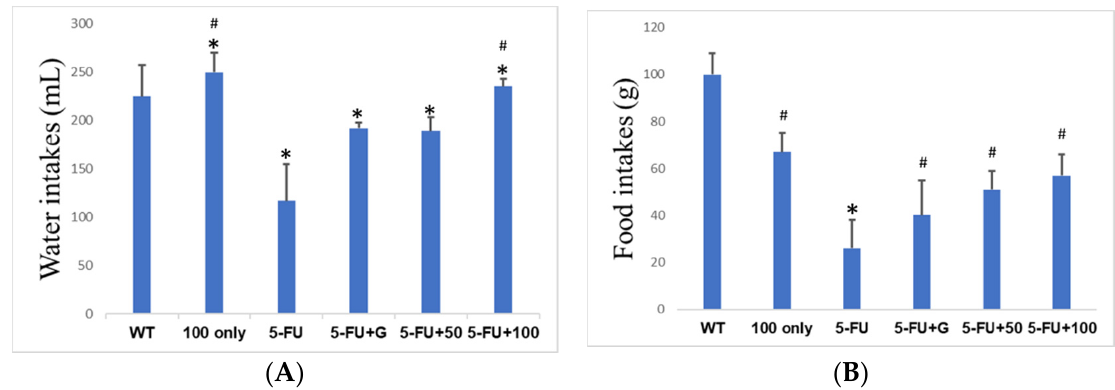
Figure 3. The food intakes ( A ) and water intakes ( B ) per rat in six experimental groups during treatments. All values are expressed as mean ± SD in each group. *: p < 0.05 versus the WT group and # : p < 0.05 versus the 5-FU group.